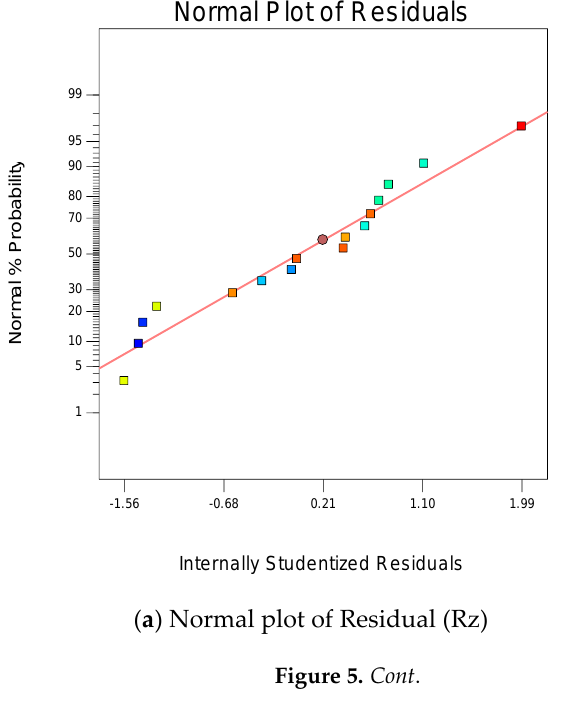
( a ) Normal plot of Residual (Rz) ( b ) Residual versus Predicted (Ra) Figure 5. Cont